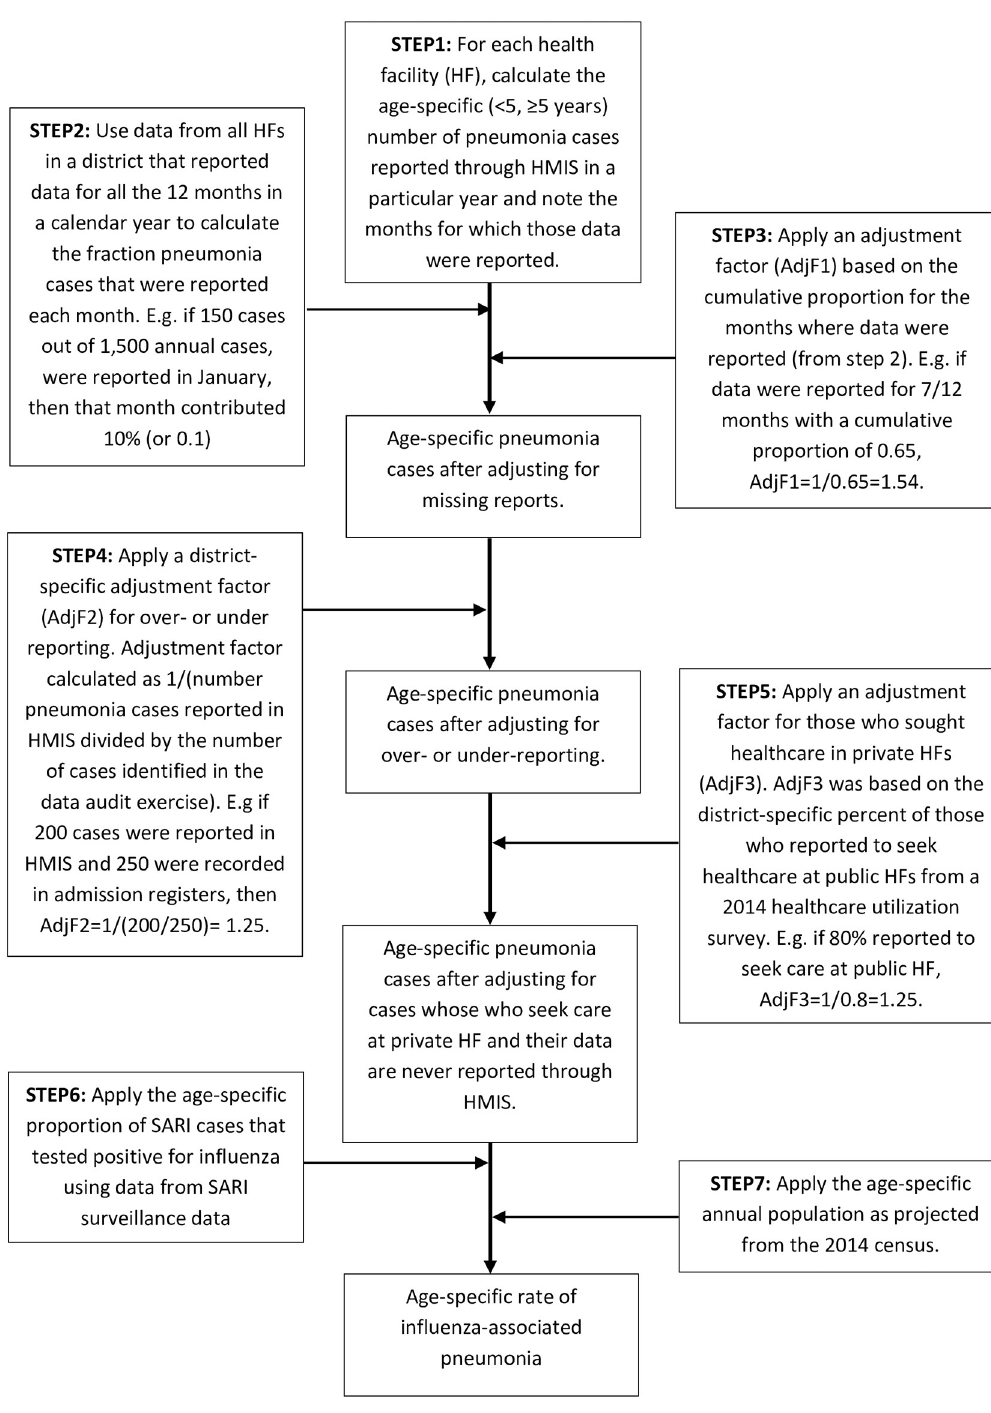
Fig 2. Flow chart showing the steps for